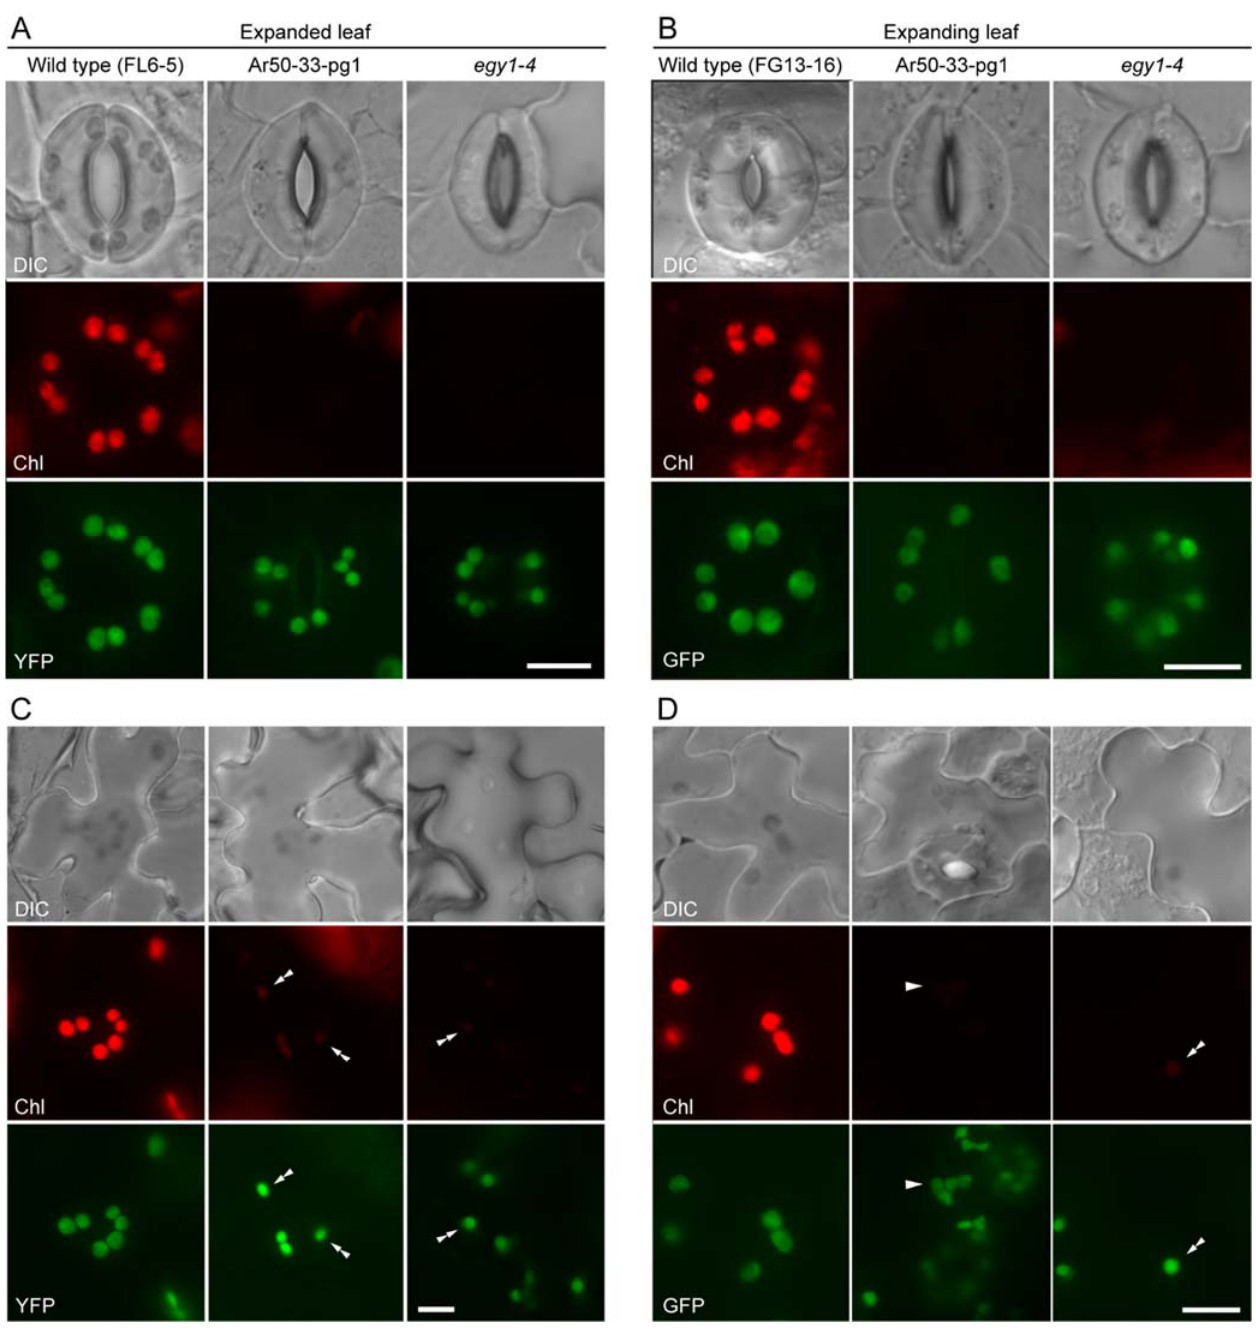
Figure 4. Fluorescence microscopy analysis of leaf epidermis in the wild type and in mutant lines expressing stroma-targeted fluorescent proteins. ( A , B ) Guard cells in fully expanded ( A ) and expanding ( B ) leaves. ( C , D ) Pavement cells in expanded ( C ) and expanding ( D ) leaves. In ( A , C ), DIC, chlorophyll autofluorescence (Chl) and YFP images of the primary leaves of 3-week-old wild-type (FL6-5), Ar50-33-pg1 (Ar50-33-pg1 × FL6-5), and egy1-4 ( egy1-4 × FL6-5) transgenic seedlings are shown, while in ( B , D ), DIC, Chl, and GFP images of the third and fourth expanding leaves of 18-day-old wild-type (FG13-16), Ar50-33-pg1 (Ar50-33-pg1 × FG13-16), and egy1-4 ( egy1-4 × FG13-16) transgenic seedlings are shown. Double arrowheads in ( C , D ) indicate the presence of chloroplasts. Arrowheads in ( D ) correspond to those in Figure S6 and indicate pavement cell chloroplasts. Chl images in ( A – D ) were captured under the same microscopic conditions. Bar = 10 µm. To evaluate the effects of mutations in EGY1 on the replication of epidermal cell chloroplasts or plastids, we counted the number of GFP-positive plastids in mature guard cells of PDF1 p:: TP SIG6 -GFP -expressing wild-type (FG13-16), Ar50-33-pg1